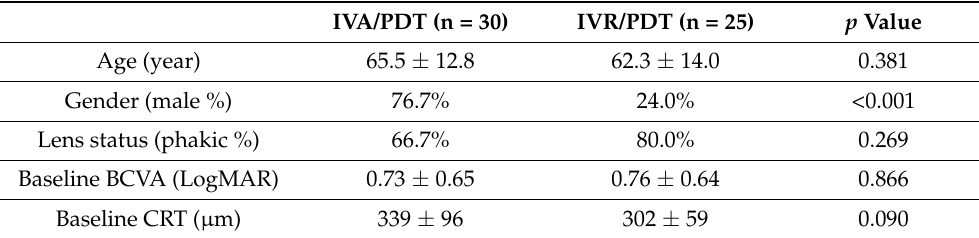
Table 1. Baseline characteristics of patients in two treatment